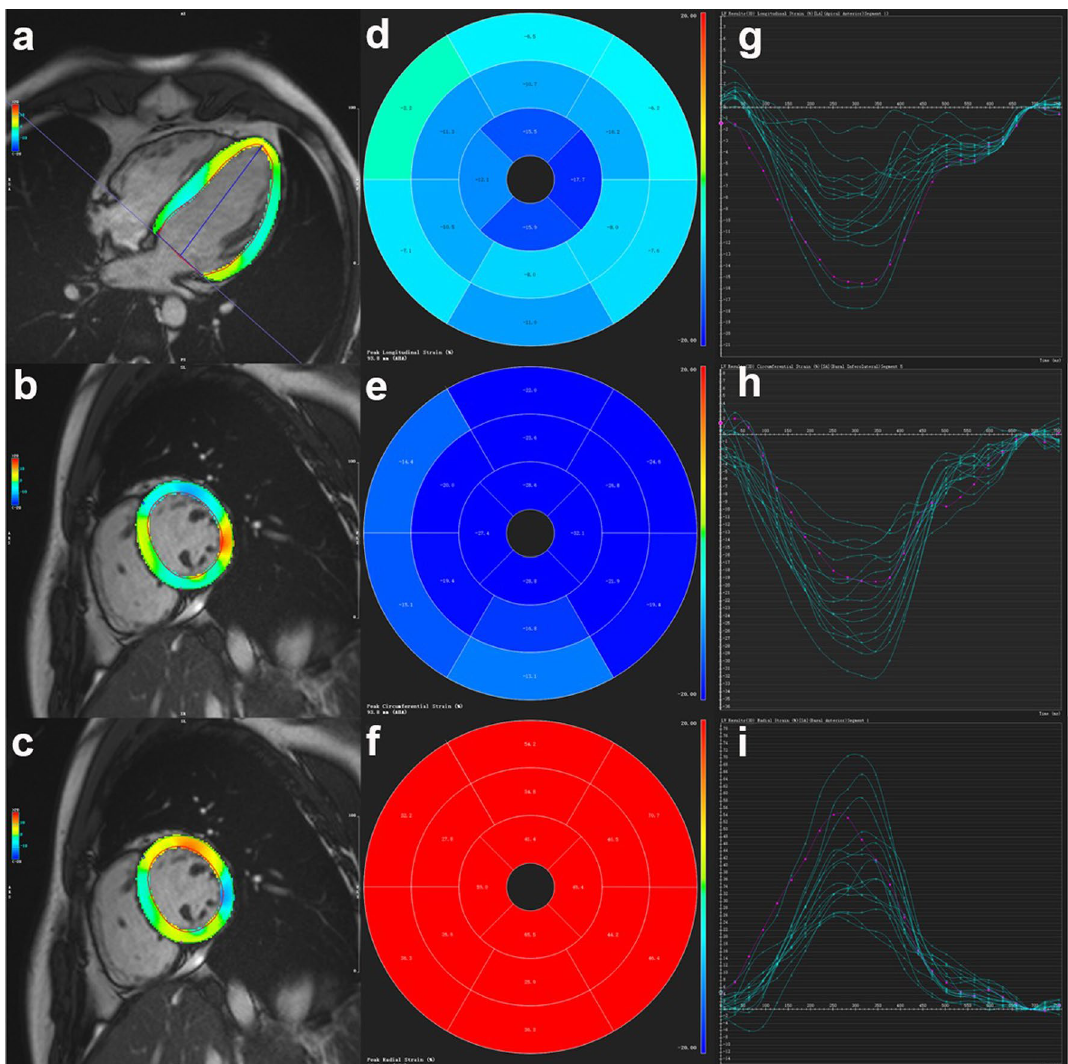
Figure 3. Example of left ventricular myocardium peak systolic strain analysis in a healthy volunteer. The left shows the colored tissue-tracking maps of longitudinal ( a ), circumferential ( b ), and radial ( c ) strain. In the middle is the 16-segment model of the longitudinal ( d ), circumferential ( e ), and radial ( f ) values in a cardiac cycle. On the right are the strain–time curves of the longitudinal ( g ), circumferential ( h ), and radial ( i ) values in a cardiac